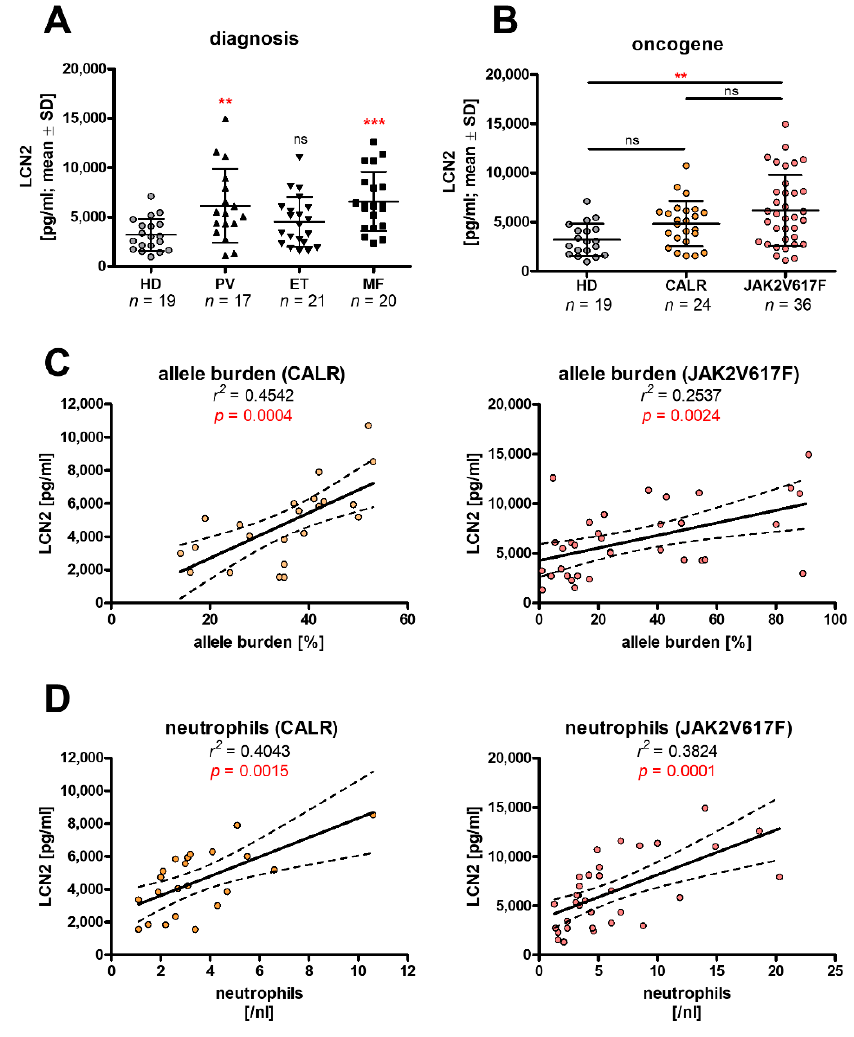
Figure 2. LCN2 serum levels are increased in PV and MF patients. LCN2 serum levels of healthy donors (HD) or patients diagnosed with polycythemia vera (PV), essential thrombocythemia (ET) or myelofibrosis (MF) were assessed from PB using the ProcartaPlex™ Multiplex Immunoassay and grouped by ( A ) diagnosis (Mann–Whitney U test) or ( B ) oncogene. (Kruskal–Wallis followed by Dunn ´ s test) ( C , D ) Correlation between LCN2 serum levels and allele burden ( C ) or neutrophil count ( D ) for patients carrying a CALR mutation (left) or JAK2 mutation (right). Linear regression analysis. Asterisks indicate p -values of: ** = p < 0.01; *** = p < 0.001. ns—not